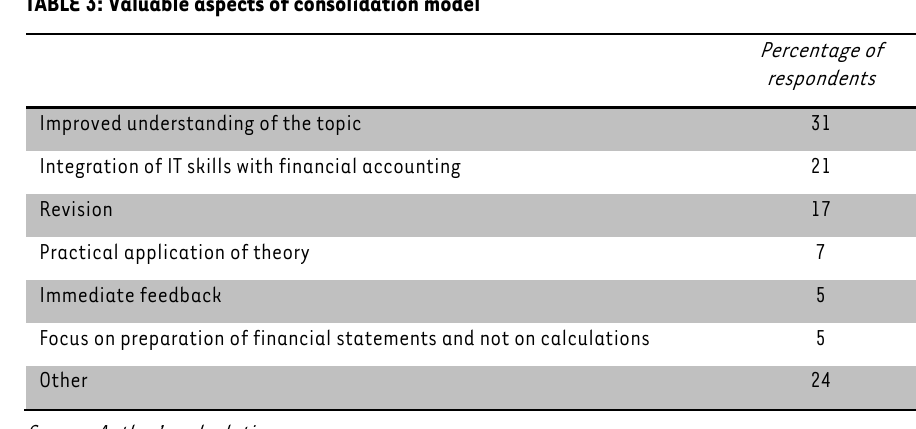
TABLE 3: Valuable aspects of consolidation model